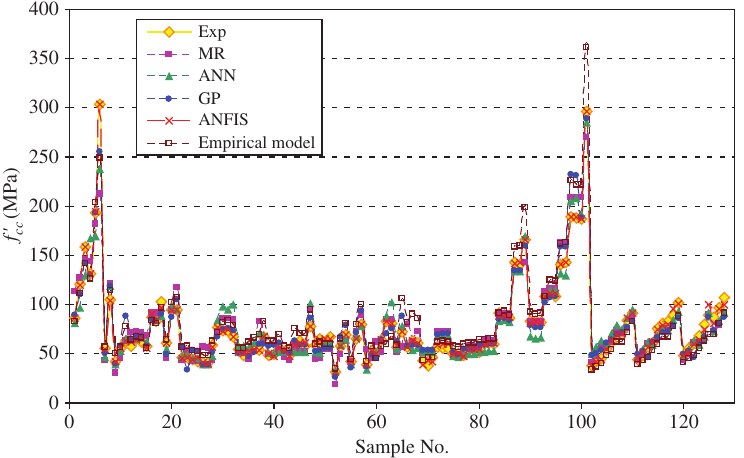
Figure 17 Experimental results along with predictions of the models.